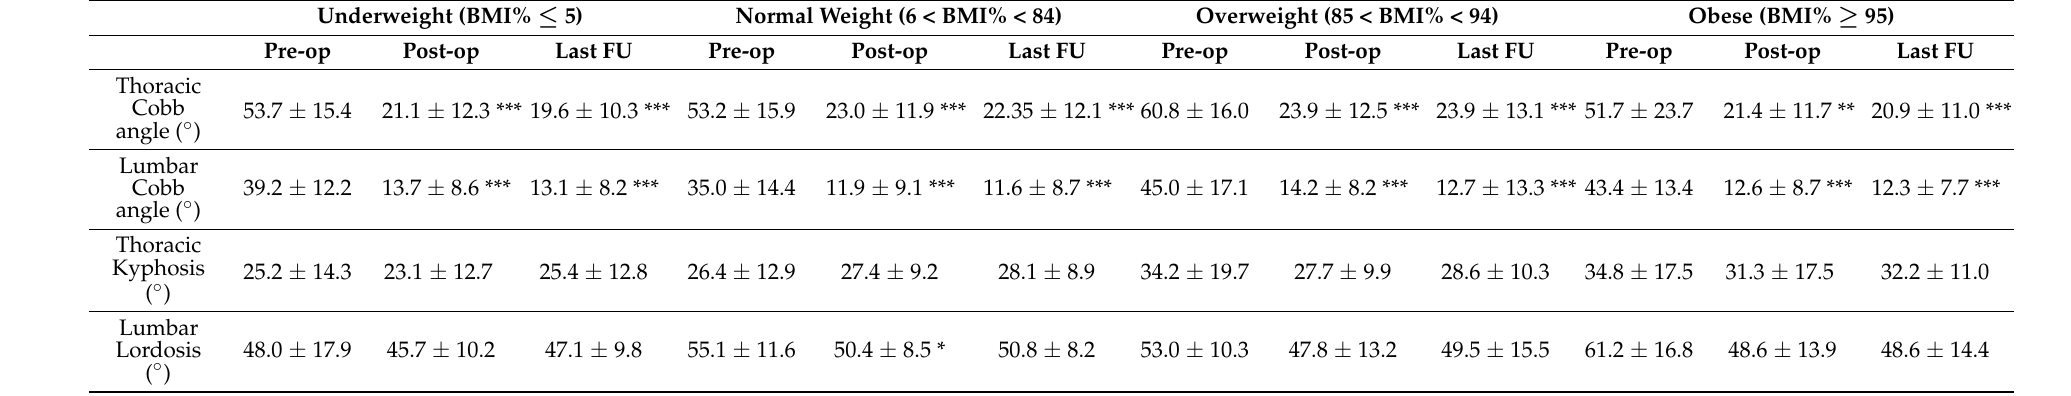
Table 4. Radiologic evaluations. * p < 0.05, ** p < 0.01, *** p < 0.001 vs. pre-op. Statistical test: two-way ANOVA for repeated measures with post hoc pairwise t test with Bonferroni’s